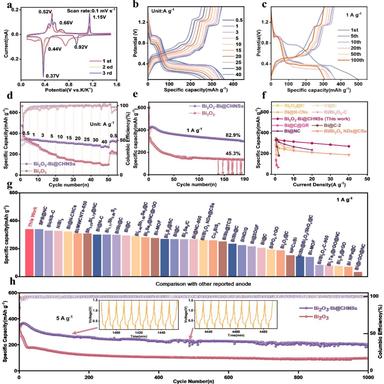
a) CV curves of Bi2O3-Bi@CHNSs. b) GCD curves tested at diverse current densities (c) GCD curves tested at 1 A g− 1 . d) Rate performance. e) Cycling property at 1 A g− 1 . f) Rate capability comparisons with other Bi-based anode materials. g) Rate capacity comparisons with other Bi-based anode materials at a current density of 1 A g− 1 . h) Long-term cycling properties at a current density of 5 A g− 1 .